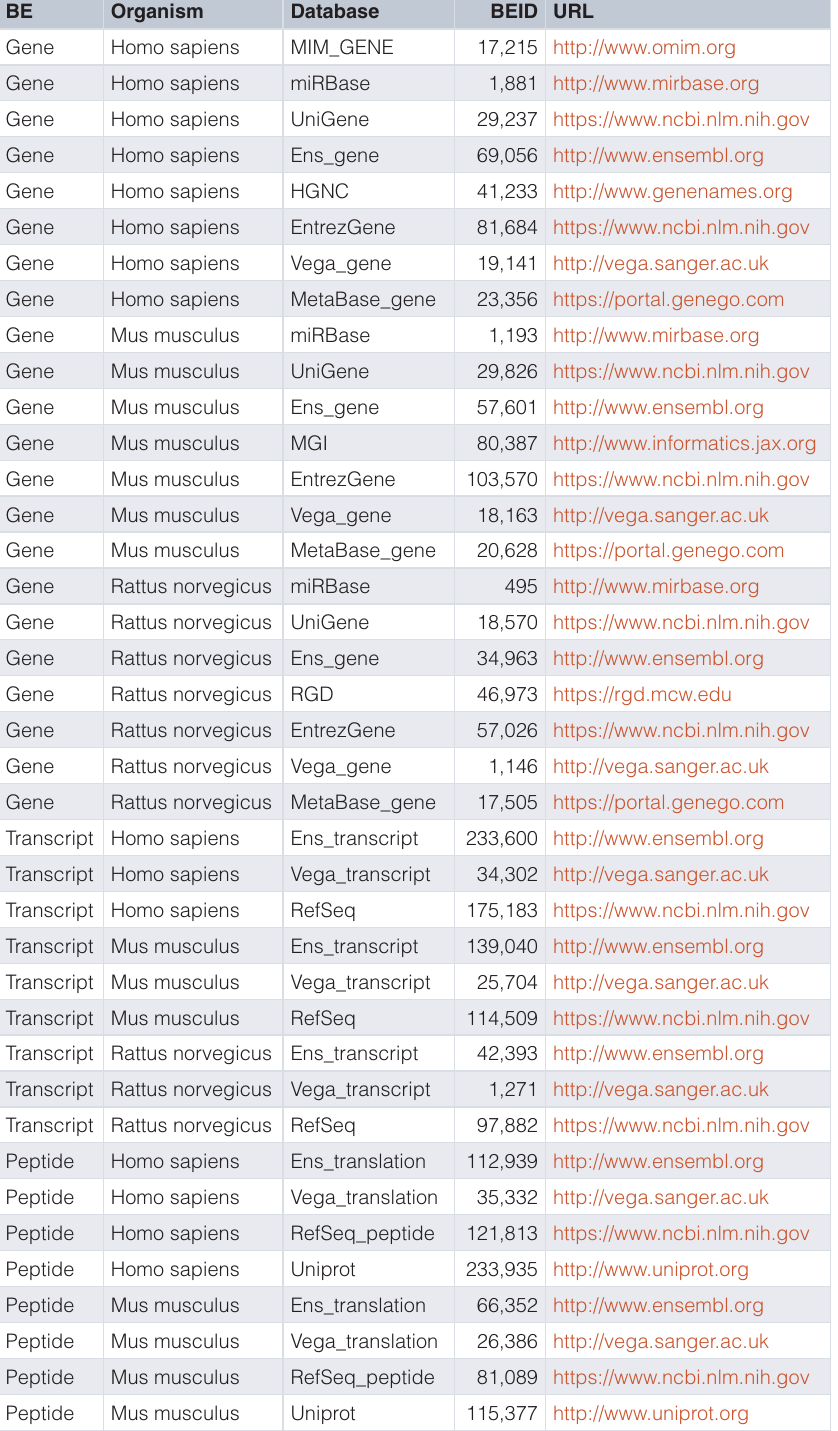
Table 1. Numbers of BEID available in the BED UCB-Human database instance. Numbers have been split according to the BEType and the organism. Only BEID which can be mapped to each other are taken into account (i.e. excluding deprecated identifiers without